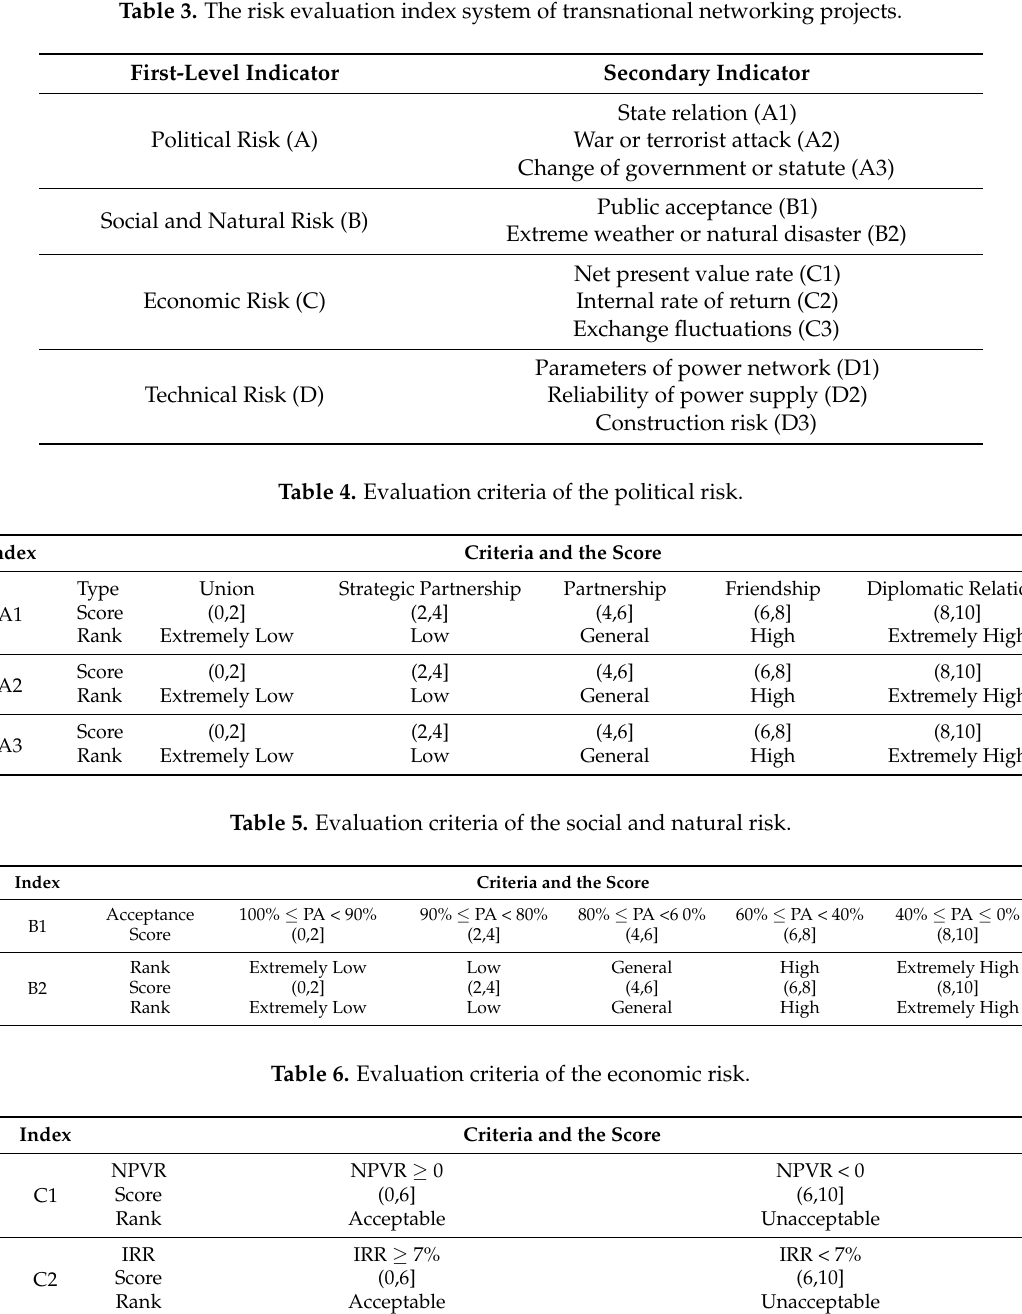
Table 3. The risk evaluation index system of transnational networking projects.